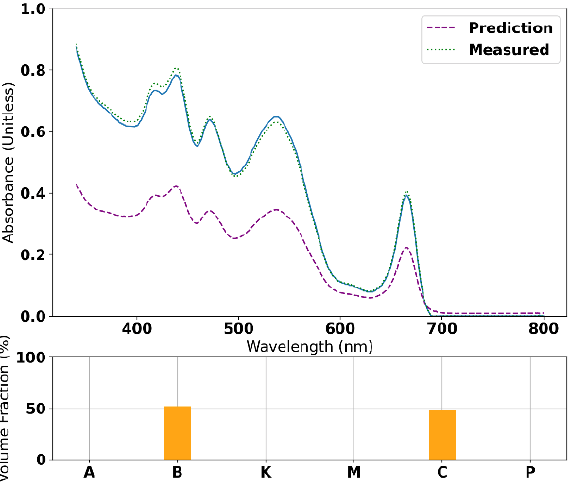
Figure A2. In contrast to the rule of mixtures shown in Figure A1, Figure A2 shows the radial basis function interpolation approach to modeling the absorbance profile of dye mixtures. Notice how the blue curve proceeds through the empirical 50/50 Betalin/Chlorophyll data while retaining the same 100% Betalin and 100% Chlorophyll profile starting points. Note: the purple curve represents the predicted absorbance for the rule of mixtures, not the RBF prediction. This purple curve is only intended to show how the RBF method succeeds where the rule of mixtures approach failed. (Download the supplementary materials to review this